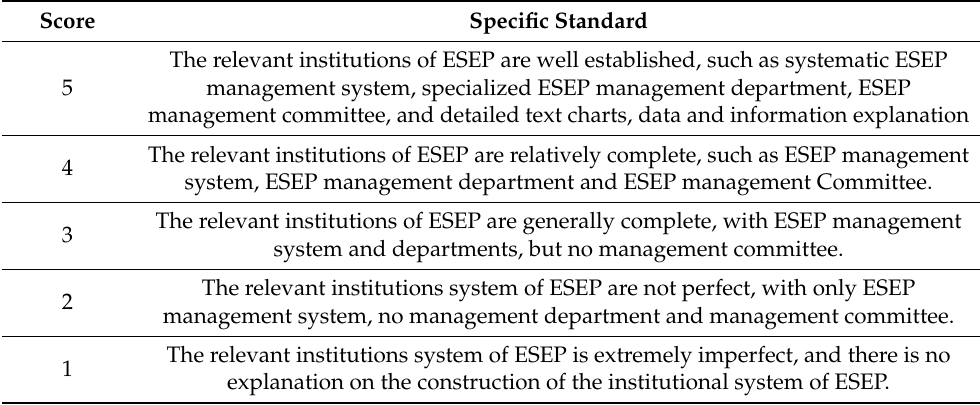
Table 2. Institutional indicators—Quantitative scoring